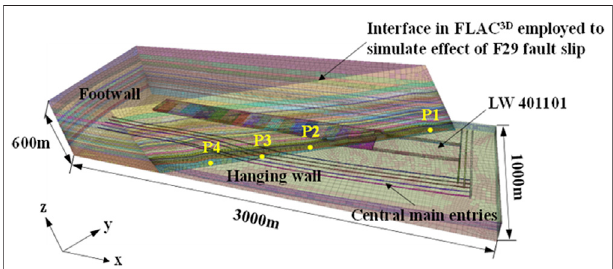
FIGURE6| Sketchmapofinitialnumericalsimulationandmeasurement points.